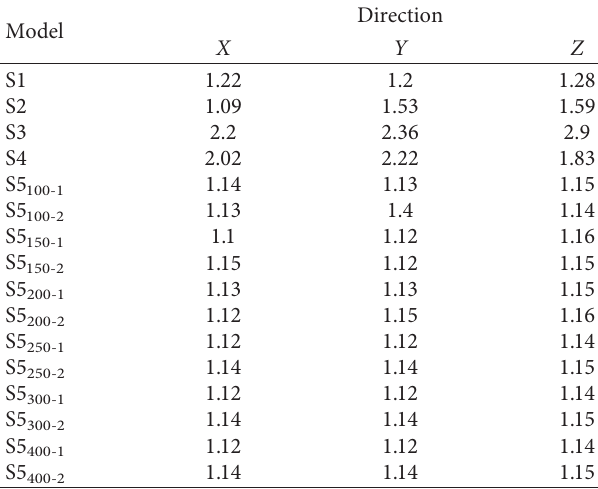
Figure 4: Schematic diagram of fluid passing through a porous medium. Table 4: Model’s tortuosity